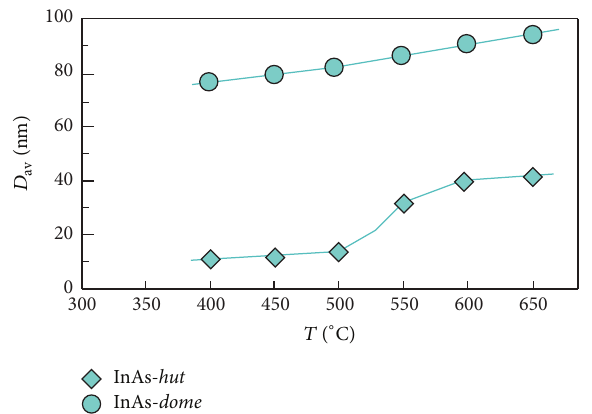
Figure 9: Surface density of InAs nanoislands as a function of ion- beam current.